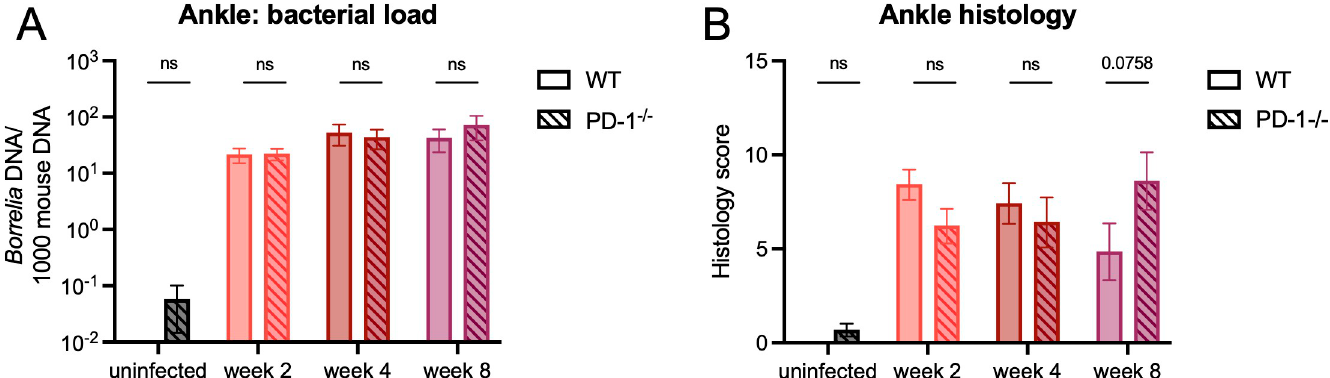
Fig 5. The role of PD-1 in controlling B . burgdorferi loads and Lyme arthritis. WT and PD-1 -/- mice were inoculated with B . burgdorferi or media alone and sacrificed at two, four, and eight weeks post-infection. (A) DNA was isolated from ankle joints and bacterial load was assessed by ddPCR. (B) Ankle joints were fixed, sectioned and stained with H&E and scored blindly by a pathologist for synovitis, tenosynovitis/tendonitis, periarticular fibrosis, synovial proliferation, articular cartilage degeneration or erosion, periosteal remodeling, and effusion/edema. Data are representative of three experiments pooled with at least five mice per infected group and were analyzed using (A) two-way ANOVA with Sidak’s multiple comparisons test and (B) Mann-Whitney test.